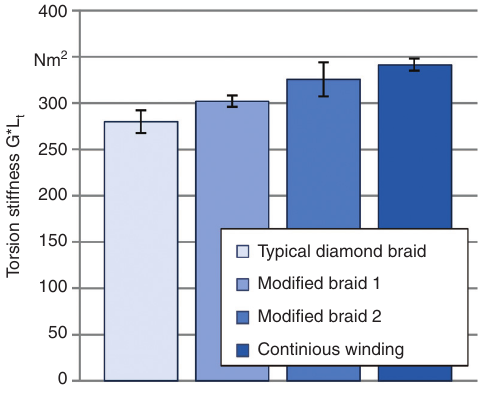
Figure 17 Torsional stiffness of specimens with different textile